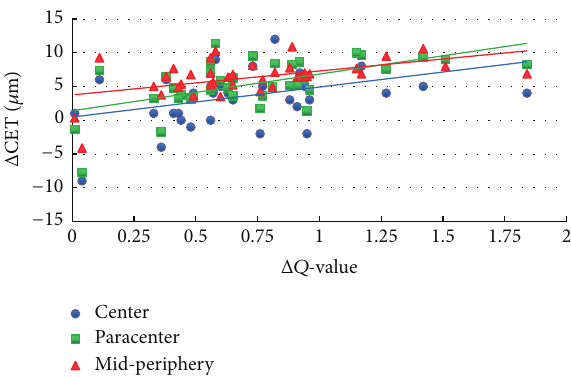
Figure 4: Correlation between Δ CET and Δ𝑄 -value 6 months